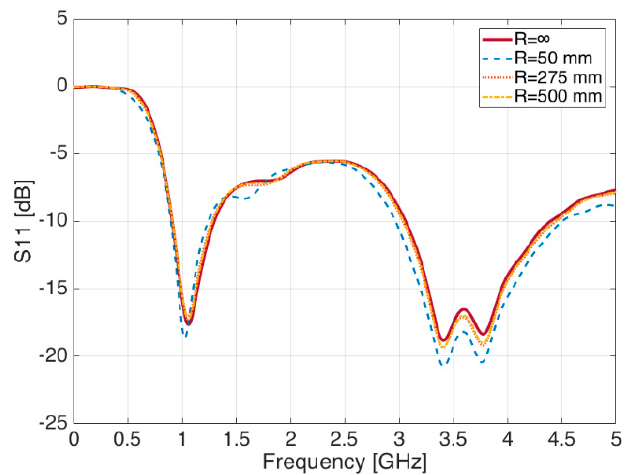
Figure 9. Reflection coefficient S 11 for different values of ‘R’—Bending in the ‘Y’ direction.